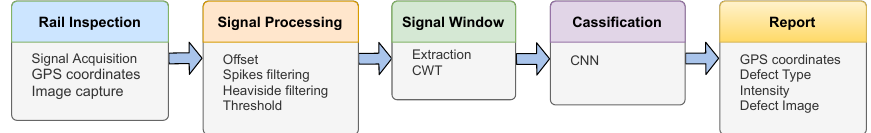
Figure 5. Step diagram for detecting surface defects on